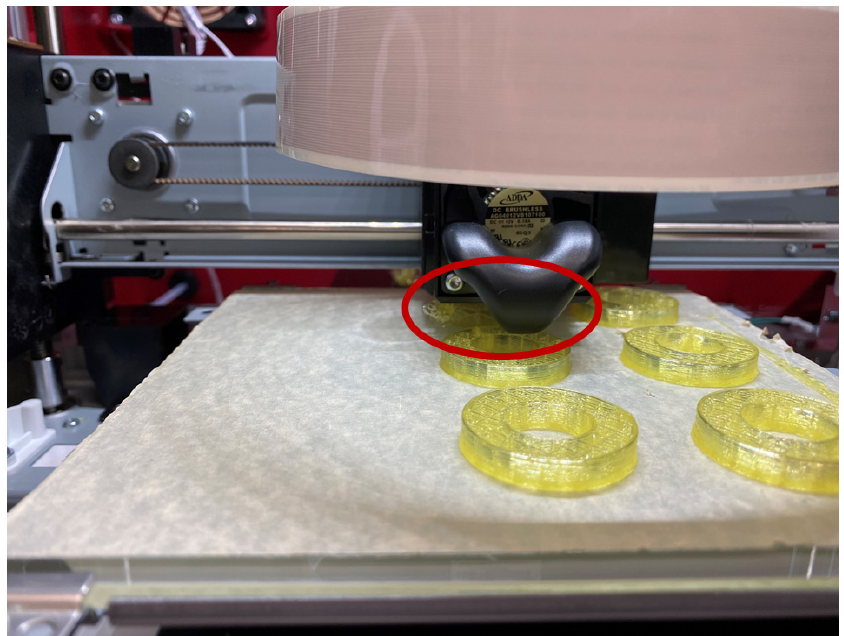
Figure 6. Nozzle blockage fault in a 3D printing machine.